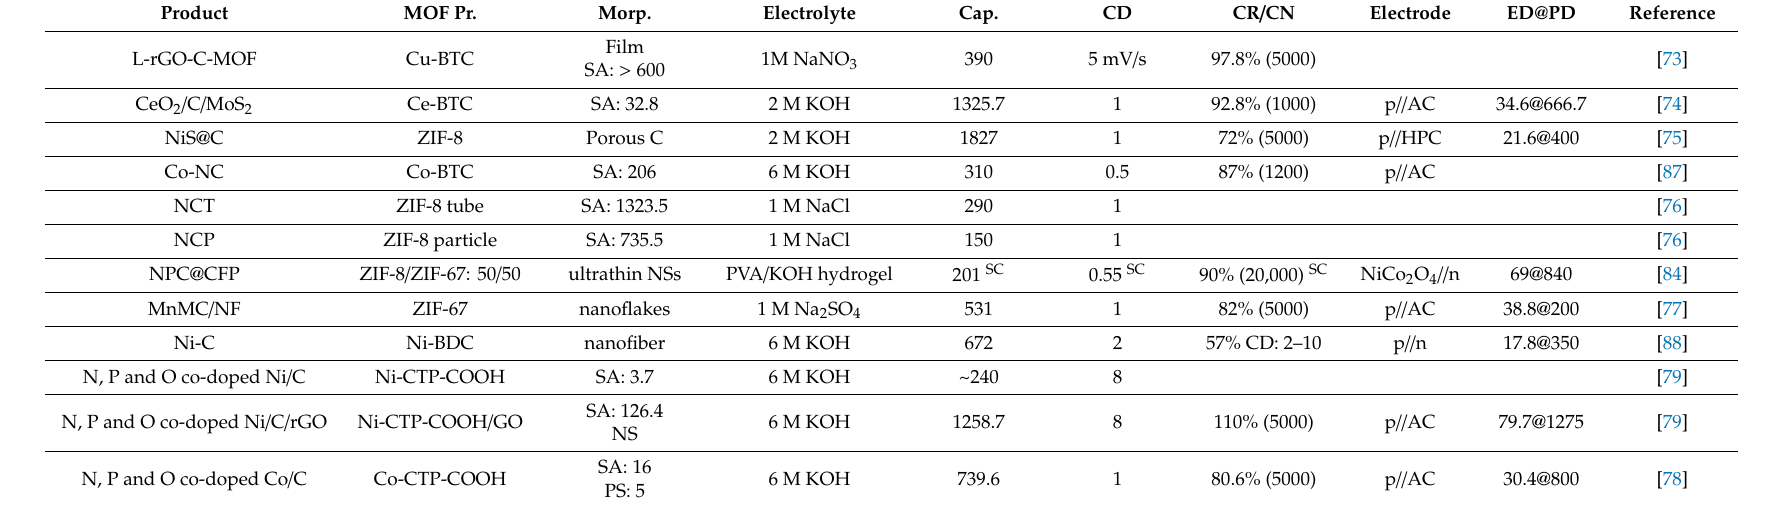
Table 2. Selected MOF-derived C-based electrodes for supercapacitor applications. MOF pr., MOF precursor; Morp., morphology. The same below.